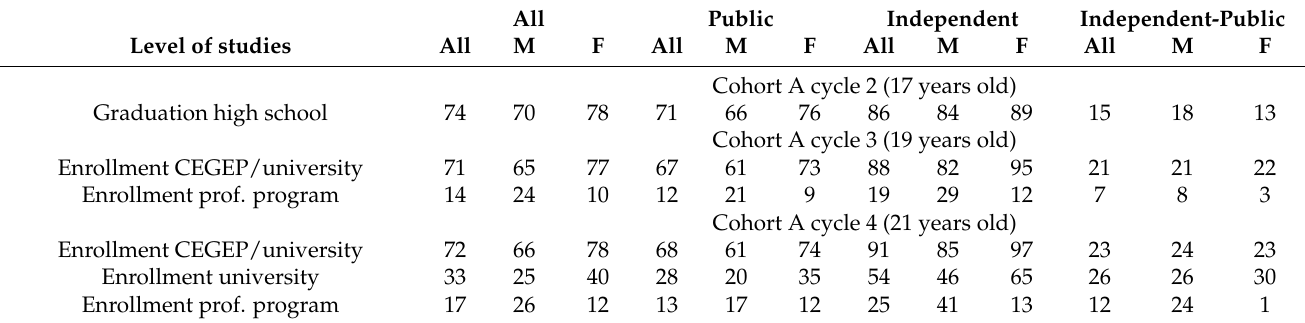
Table 2. Enrollment and graduation rate by sex, cycle, level of studies, type of high school, and difference by school type, percentages, and number of observations.